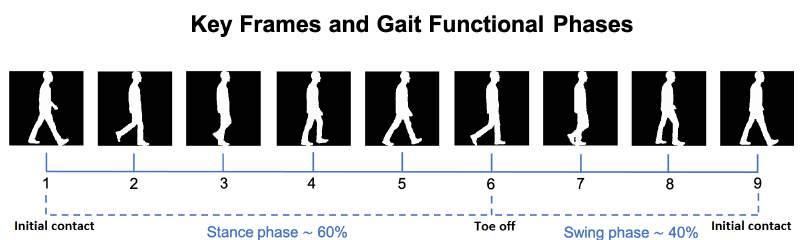
Figure 2. Example of the silhouettes in the 9 key frames representing a normal walking gait cycle, along with the 8 gait phases in between consecutive key frames.